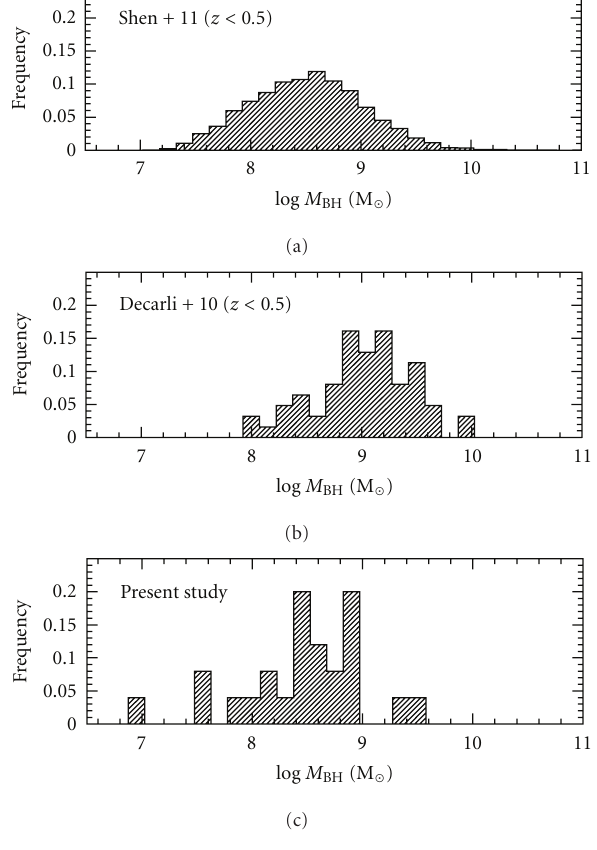
Figure 1: Comparison among the M BH distributions in the SDSS quasars at z < 0 . 5 [27] (a), in our 2010 study (b) and in the present work (c). The latter is clearly more representative of the general quasar population at low redshift.